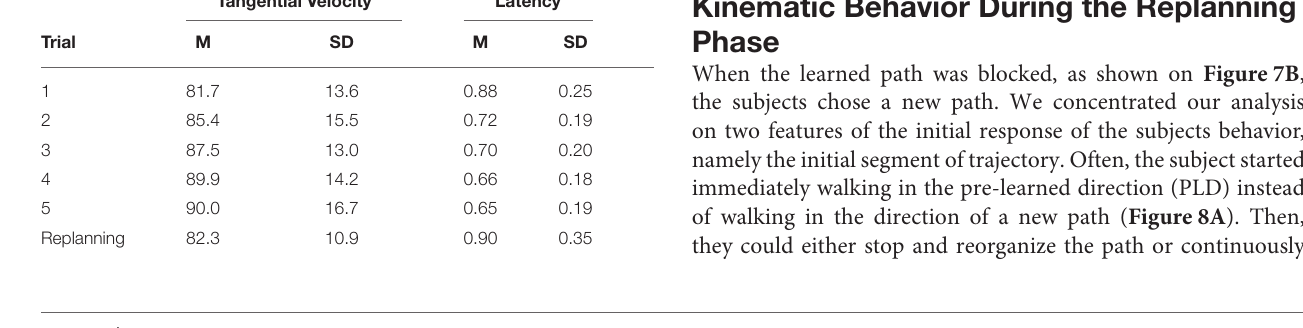
TABLE 3 | Median and range quartile (Q1–Q3) of the tangential velocity and the latencies by trials. ( n ) represent the number of observations. Dependent variable